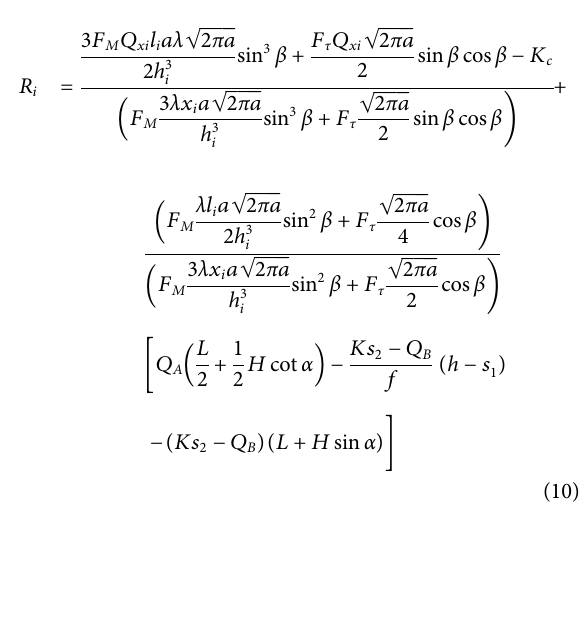
Frontiers in Earth